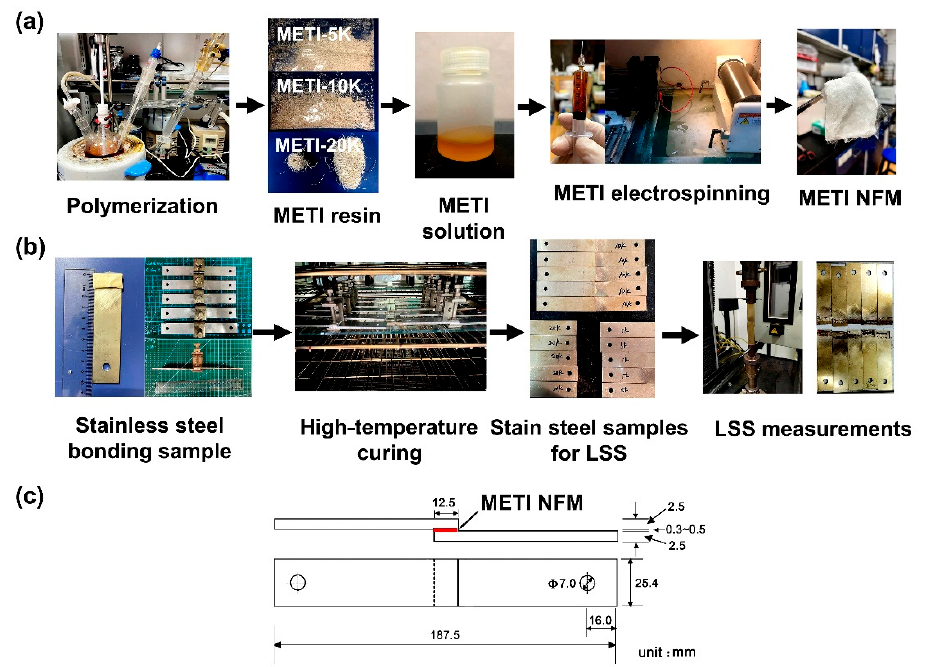
Figure 3. ( a ) Electrospinning process for METI NFMs; ( b ) Fabrication of stainless steel adherends and the lap shear strength (LSS) measurements; ( c ) Schematic diagram of the dimensions of stainless steel adherends for adhesion.